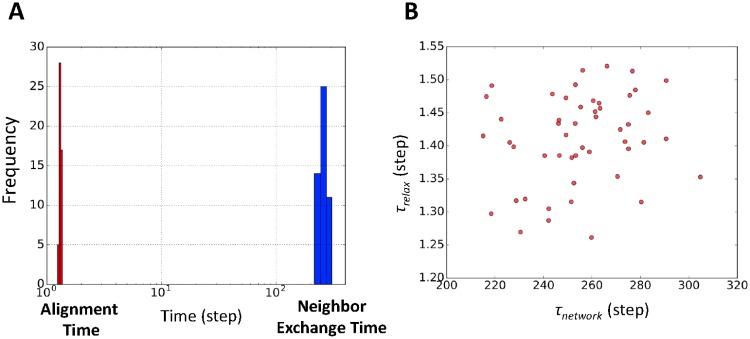
Local equilibrium in flocks.(A) Histogram of alignment time τrelax (red bars) and neighbor exchange time τnetwork (blue bars). The vertical line is the frequency for 50 simulations. Alignment time 1/Jnc is almost equal to 1 step in our simulation where nc = 5. (B) The scatter plot of τrelax versus τnetwork shows no correlation (Pearson correlation coefficient: 0.02).